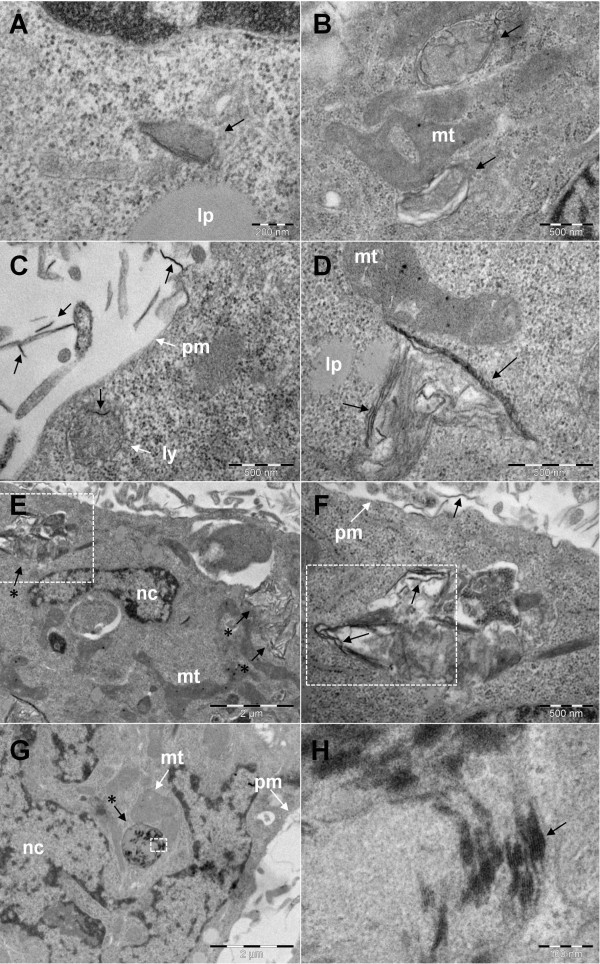
Intracellular fate of GO nanoplatelets. A) GO nanoplatelet freely localized (black arrow) in the cytoplasm. B) Degraded mitochondria (mt #). C) Interaction of a GO nanoplatelet (black arrow) with a lysosome (ly). For comparative purposes extracellular GO nanoplatelets are highlighted (black arrows). D) Interaction of cytosolic GO nanoplatelets with a mitochondrion (mt). E) Intracellular aggregation of GO nanoplatelets (black arrows with asterisks). F) High-magnification image of the boxed-in area in E showing a vesicle with GO nanoplatelet aggregates and degraded cell organelles. GO nanoplatelets (inside and outside the cell) are exemplarily indicated with black arrows. G) Phagosome-like vesicle with aggregates of GO nanoplatelets (arrow with asterisk) in close proximity to mitochondria (mt). H) High-magnification image (250000X) of the boxed-in area in G showing the laminar nature of the enclosed material (black arrow). Scale bars are 200 nm in A, 500 nm in B, C, D and F, 2 μm in E and G, and 100 nm in H.